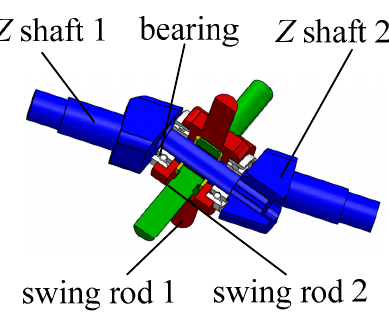
Figure 5. The structure diagram of the output module.